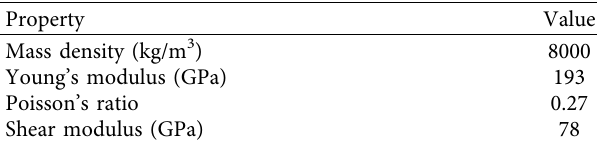
Table 5: Physical properties for stainless steel